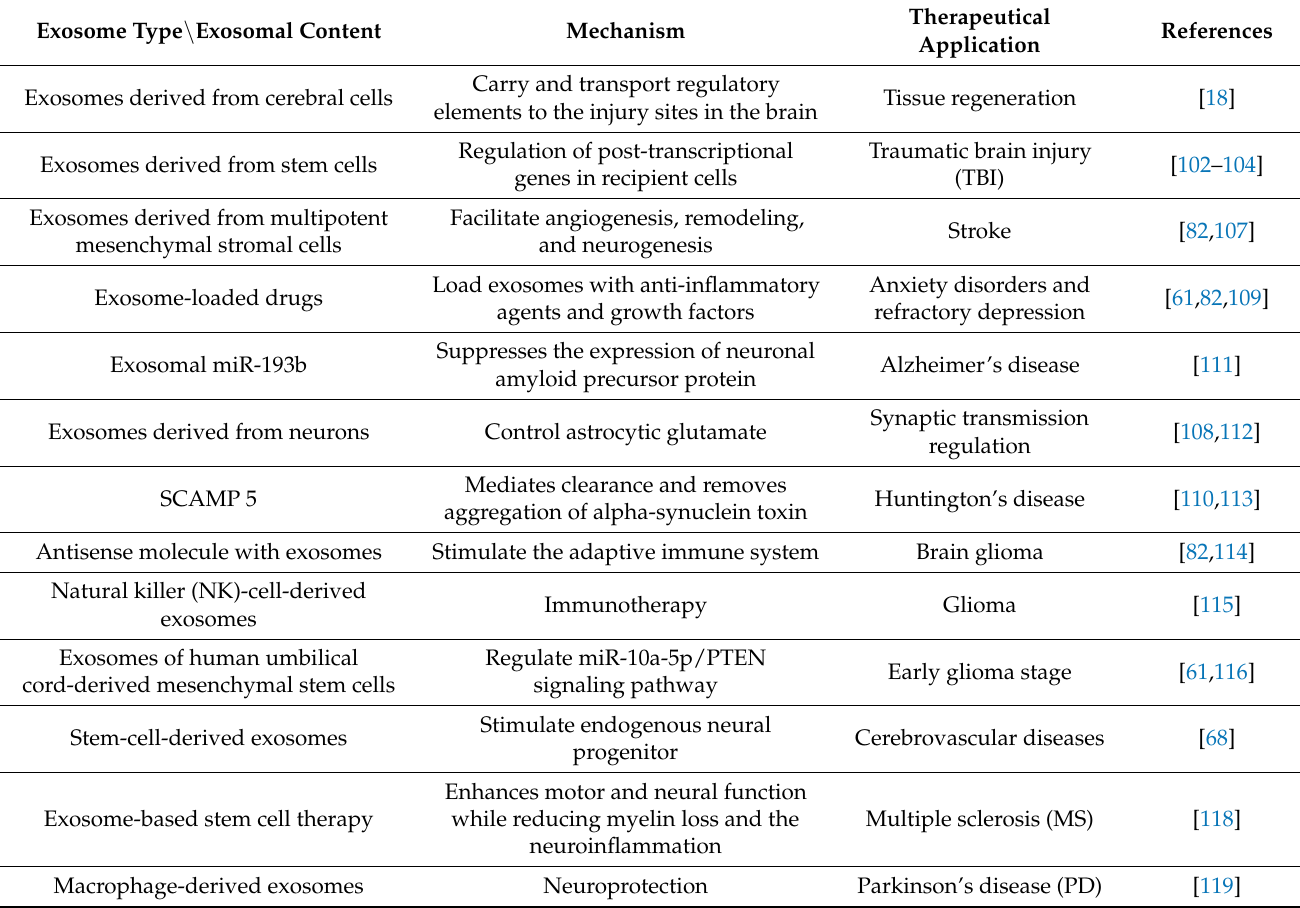
Table 3. Therapeutical applications using